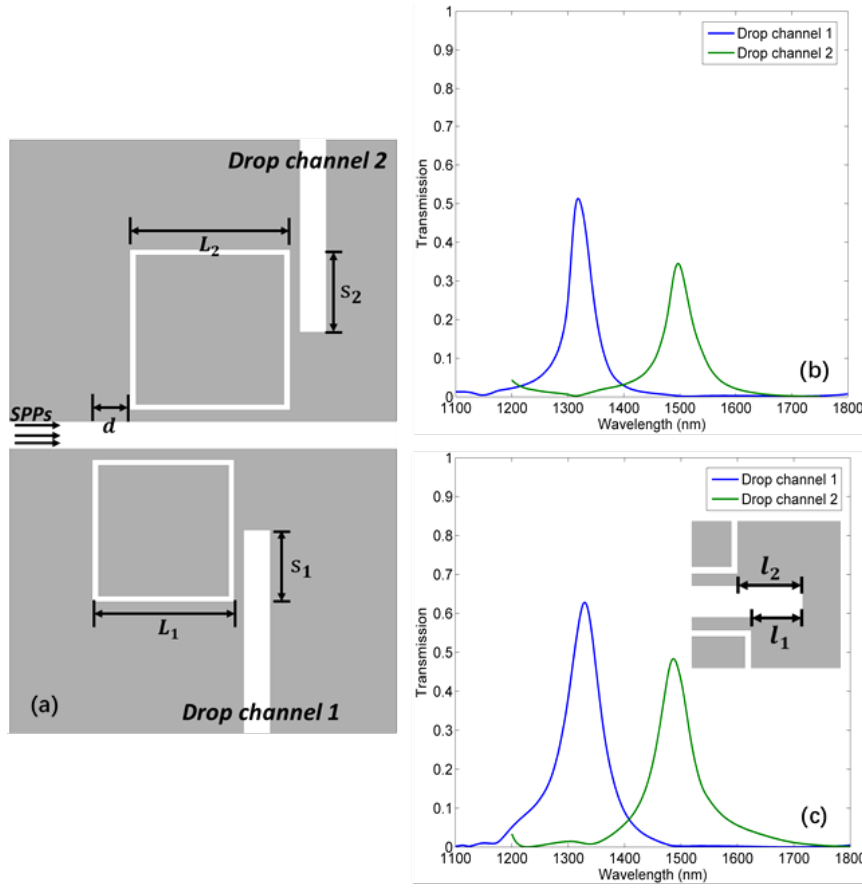
Figure 5. ( a ) The schematic diagram of the dual demultiplexer. L 1 = 546 nm, L 2 = 620 nm, s 1 = 320 nm, s 2 = 370 nm, g = 15 nm, d = 80 nm. ( b ) The drop spectrum of channels 1 and 2 without a reflector. ( c ) The drop spectrum of channels 1 and 2 with a reflector. The inset is the reflector, l 1 = 34 nm, l 2 = 46 nm.